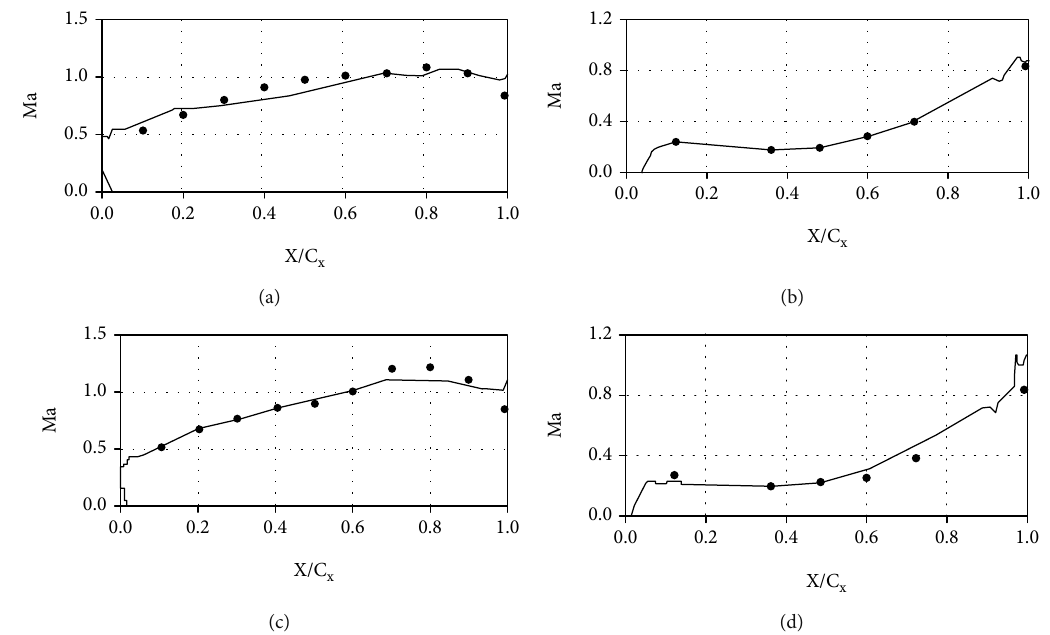
Figure 4: Central blade isentropic Mach number distributions for (a) suction surface at 50 percent span, (b) pressure surface at 50 percent span, (c) suction surface at 90 percent span, and (d) pressure surface at 90 percent span.